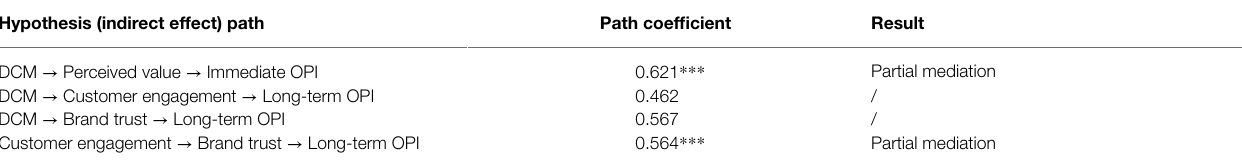
TABLE 8 | The mediation